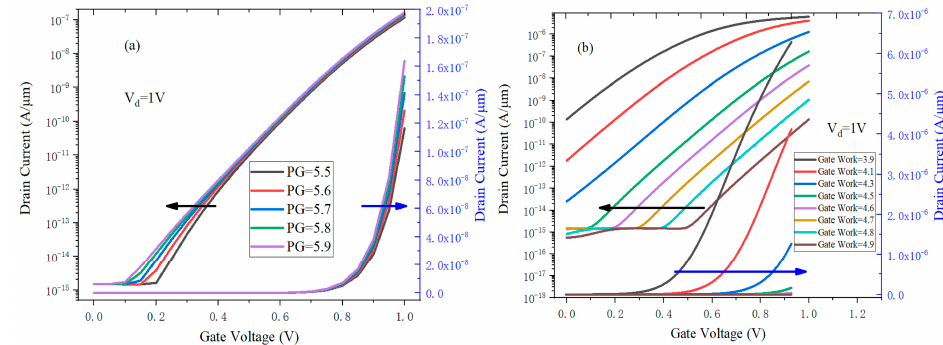
Figure 8. The effect of the gate work function on the transfer characteristics ( a ) the polar-gate work function; and ( b ) the control-gate work function.